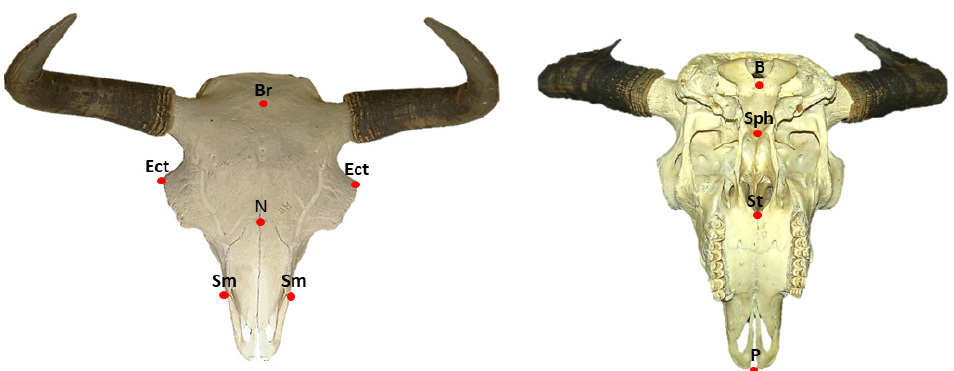
Figure 1. Measurement points on the European bison